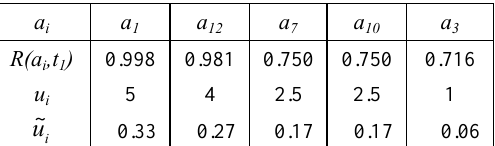
Table 8. List of independent descriptors relevant to t 1